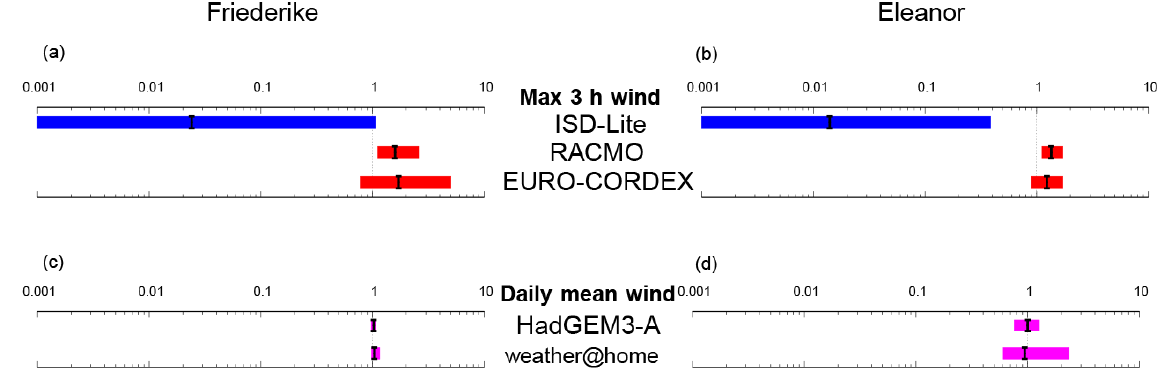
Figure 10. Synthesis of the probability ratios (PRs) compared for storms Friederike and Eleanor. Panels (a) and (b) compare PRs for the daily maximum of three-hourly instantaneous wind speeds (blue for observations and red for models). The PRs have been converted to apply to the common interval 1975–2055 assuming the logarithm scales with the CO 2 concentration. Panels (c) and (d) compare PRs for the two models with daily mean wind speeds. The PRs have been converted to apply to the common interval 1860–2055 to show the change that occurs between pre-industrial and 1.5 ◦ C